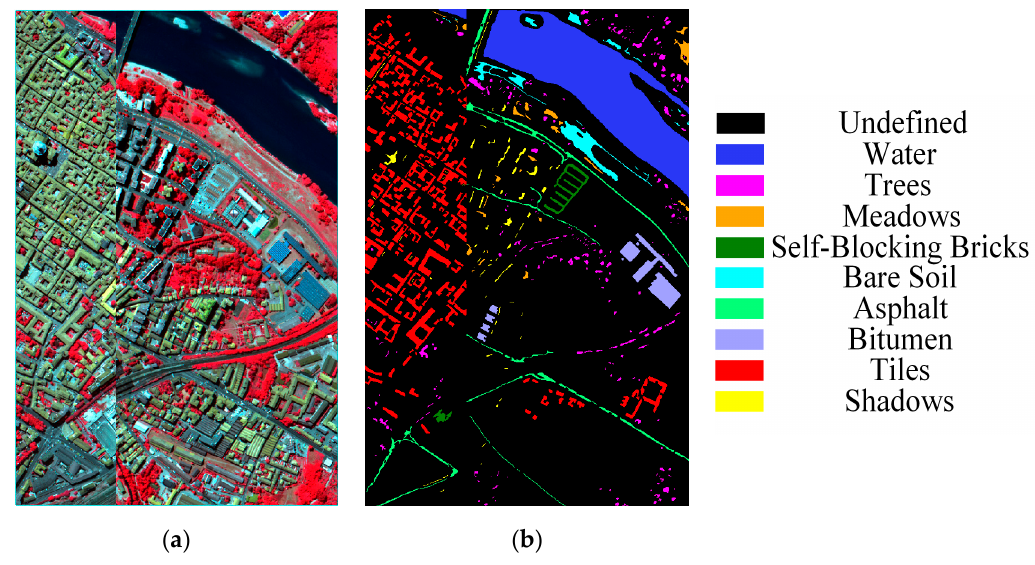
Figure 6. Pavia Center dataset: ( a ) false-color composite of Pavia Center, ( b ) ground-truth map.